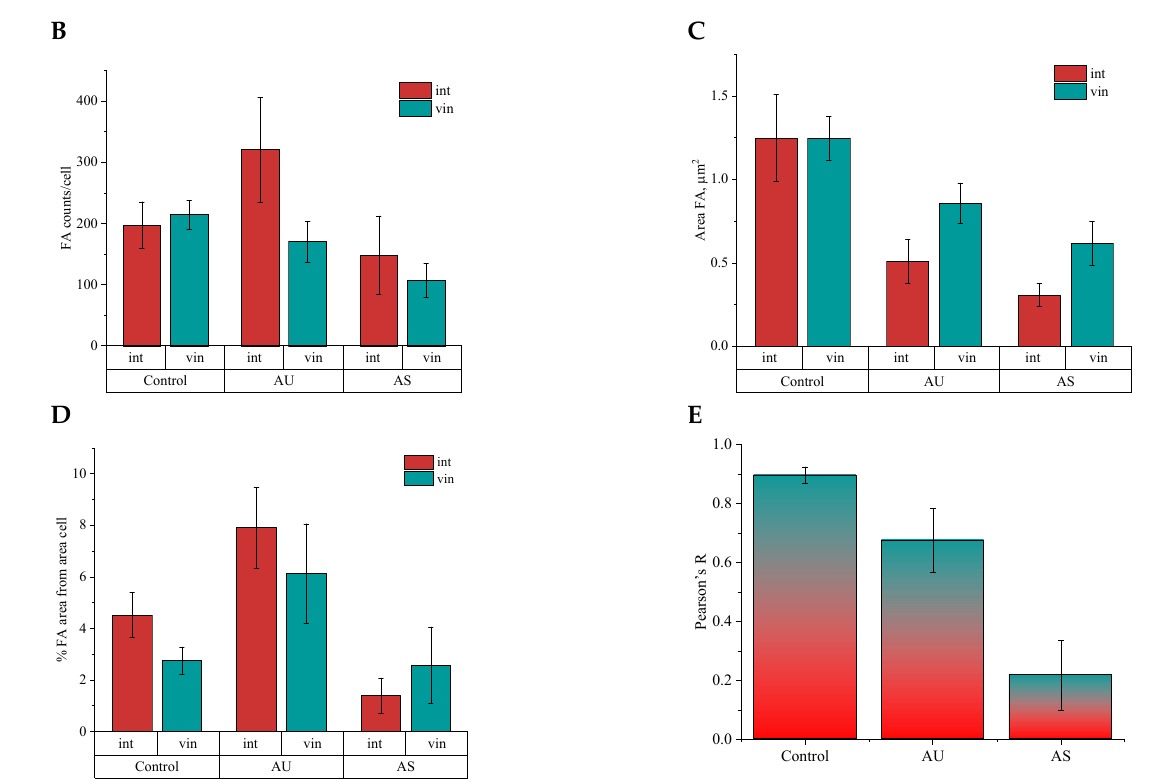
Figure 7. Formation of integrin- and vinculin-containing focal contacts of neurons cultured on glass coated with poly- D-lysine (control) and on ultrathin and submicron nylon fibers. ( A ) Confocal images of cultured neurons stained with antibodies specific for integrin β 1 (red) and vinculin (cyan), and with phalloidin for actin network imaging (green). The arrows show the fiber direction; ( B ) number of FAs per cell; ( C ) calculated area of FAs of each kind; ( D ) percentage of FA area relative to the total surface area of the cell; ( E ) colocalization of vinculin- and integrin-positive clusters by Pearson’s R. The number of analyzed cells was at least 50; scale bar—25 μ m.